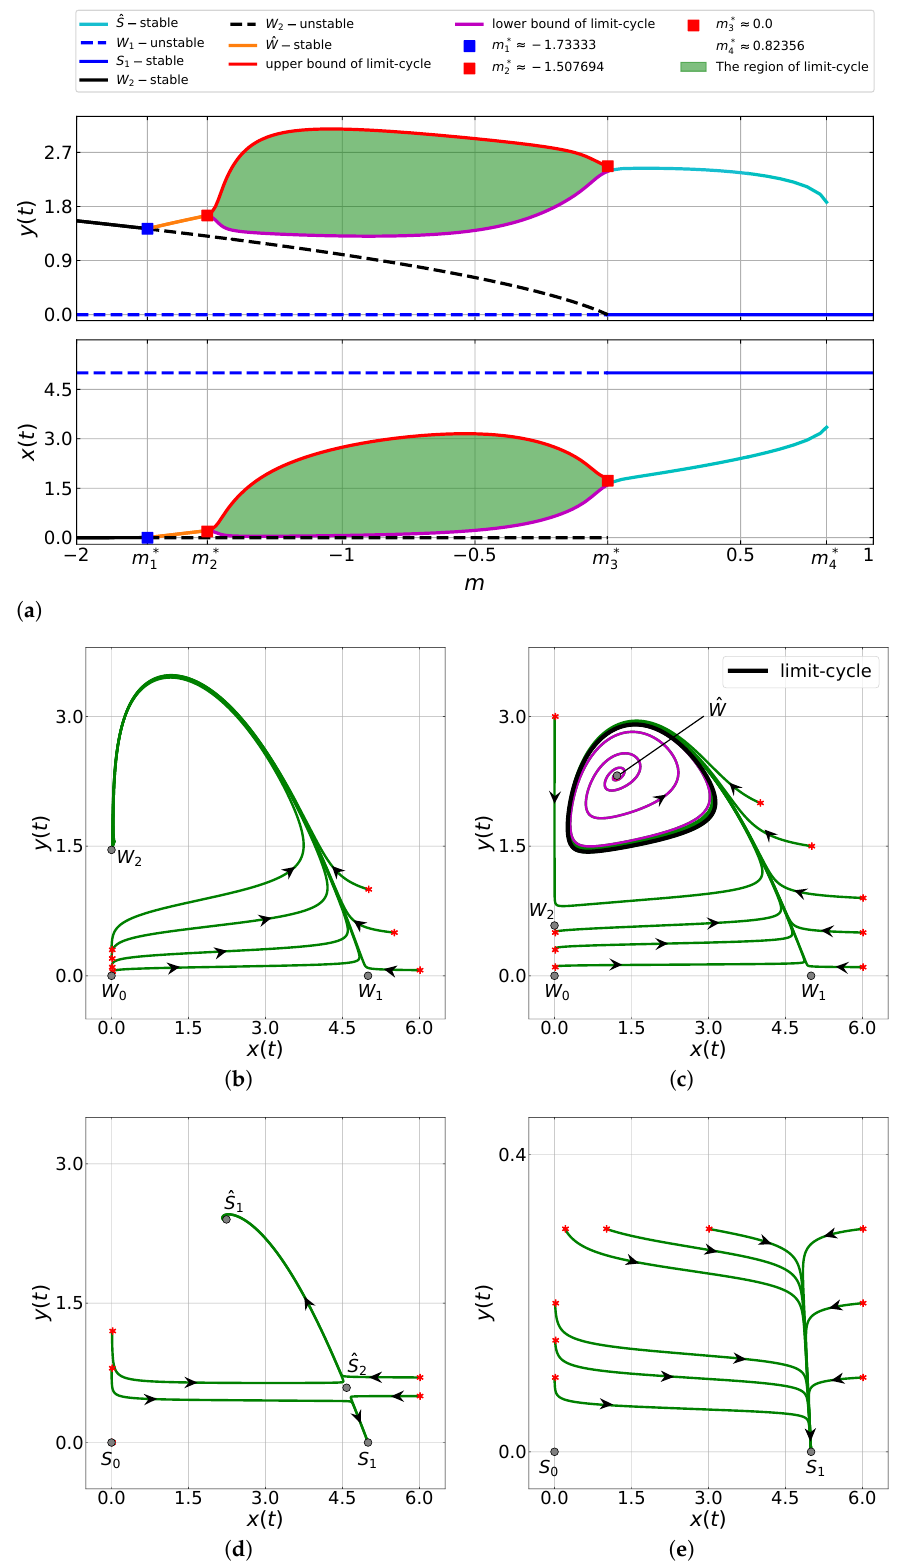
Figure 3. Dynamics of system (6) with parameter values (28) and α = 0.98. ( a ) Bifurcation diagram of system (6) driven by m . ( b – e ) Phase-portrait of system (6) with ( b ) m = − 1.79, ( c ) m = − 0.46, ( d ) m = 0.40, and ( e ) m = 0.90. The predator extinction point is unstable for the weak Allee effect case ( m < 0 ) and is locally asymptotically stable for the strong Allee effect case ( m < 0 )